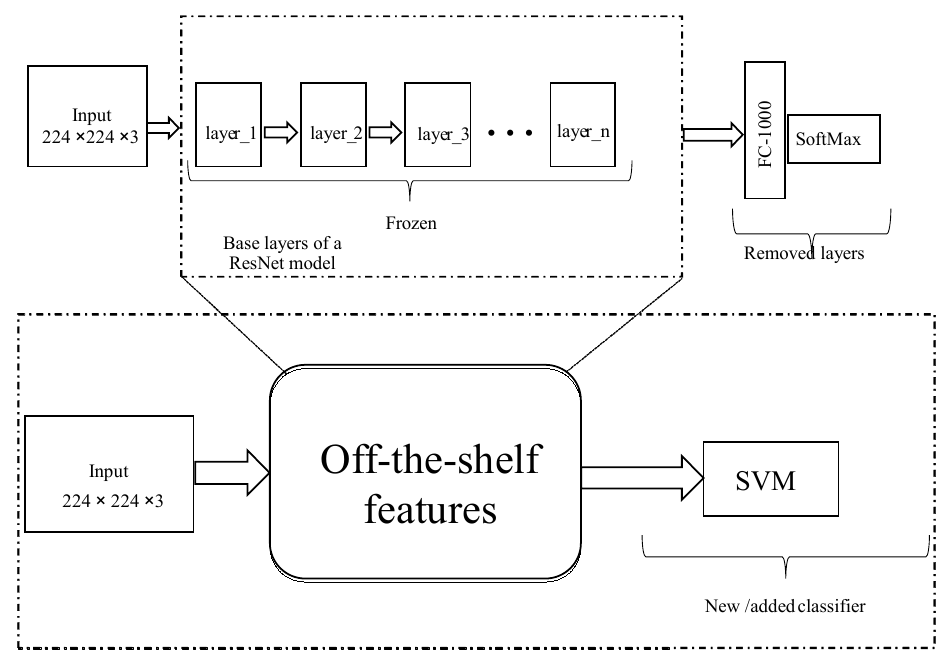
Figure 4. Illustration of o ff -the-shelf feature extraction and classification.